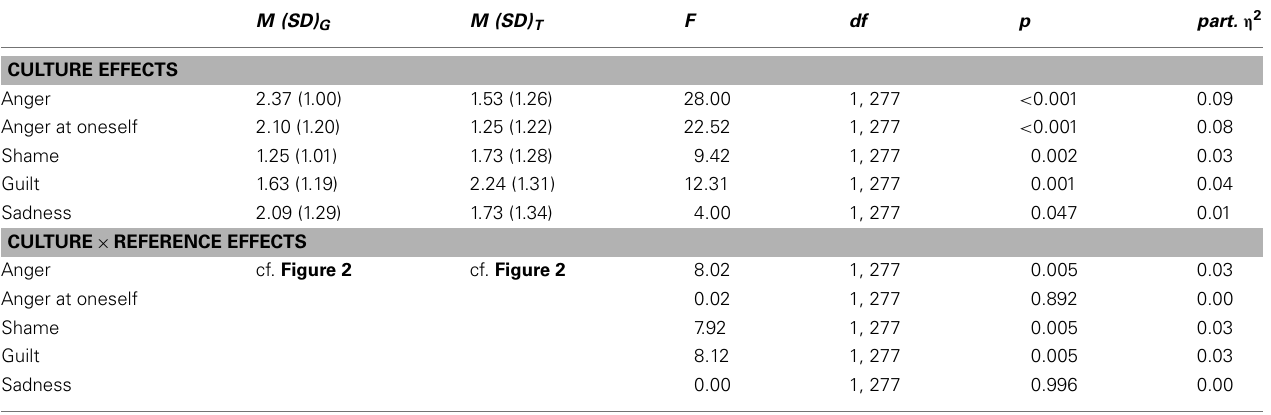
Table 1 | Univariate effects of reported emotion